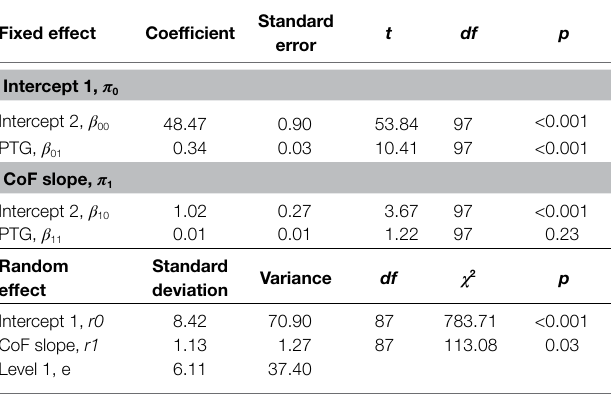
TABLE 7 | The moderating effect of PTG in the effect of COVID-19-related restrictions and concerns on committed